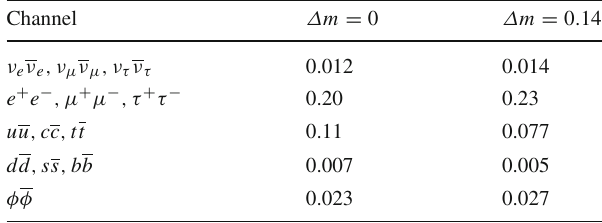
Table 1 Table with the branching ratios of the main annihilation chan- nels of B 1 B 1 → X X in terms of two values of the quark splitting mass. The last channel corresponds to a Higgs-anti-Higgs pair. Source: Ref. [6]